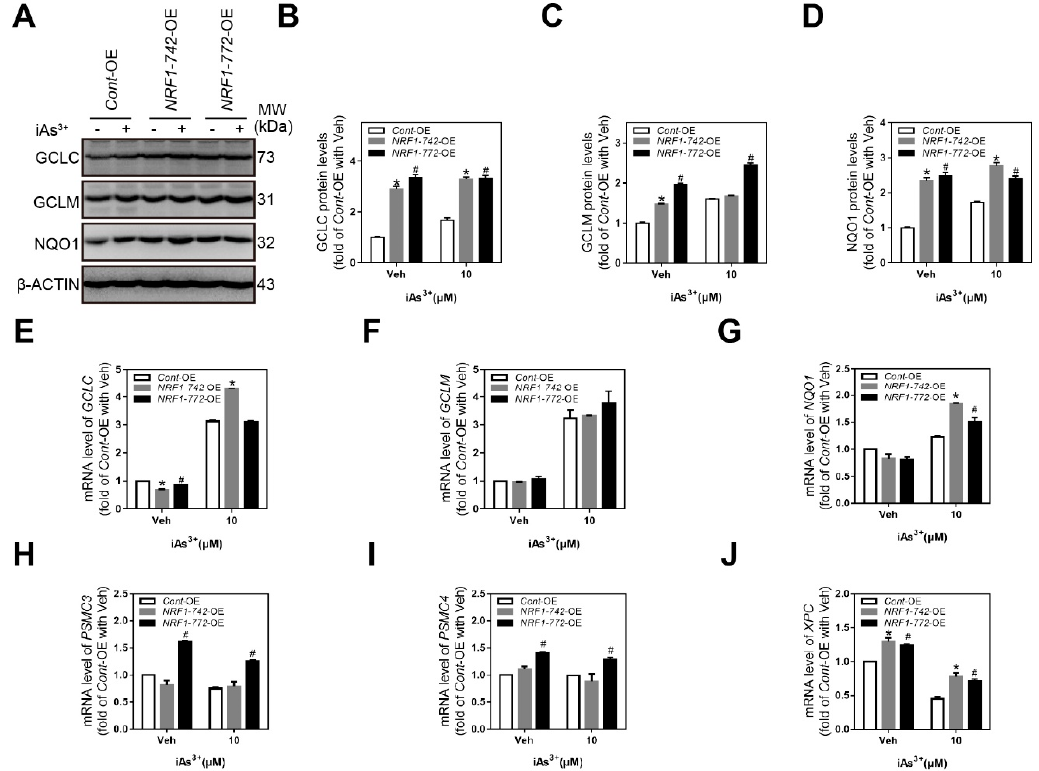
Figure 5. Expression of ARE-antioxidant genes, PSMC3 , PSMC4 , and XPC . ( A ) Antioxidant protein expression (GCLC, GCLM, and NQO1) was measured by immunoblotting after treatment with 10 µ M iAs 3 + or vehicle for 6 h. ( B – D ) Quantification of GCLC, GCLM, and NQO1 protein levels. ( E – J ) RT-qPCR analysis of the expression of antioxidant response element (ARE)-antioxidant genes ( E – G ), PSMC3 ( H ), PSMC4 ( I ), and XPC ( J ) following vehicle or iAs 3 + treatment ( n = 6). The data are presented as the mean ± SD; * p < 0.05, NRF1-742 -OE versus Cont -OE HaCaT cells; # p < 0.05, NRF1-772 -OE versus Cont -OE HaCaT cells.